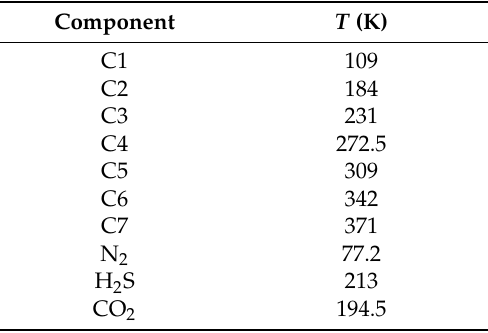
Table 3. Boiling points of flare gas